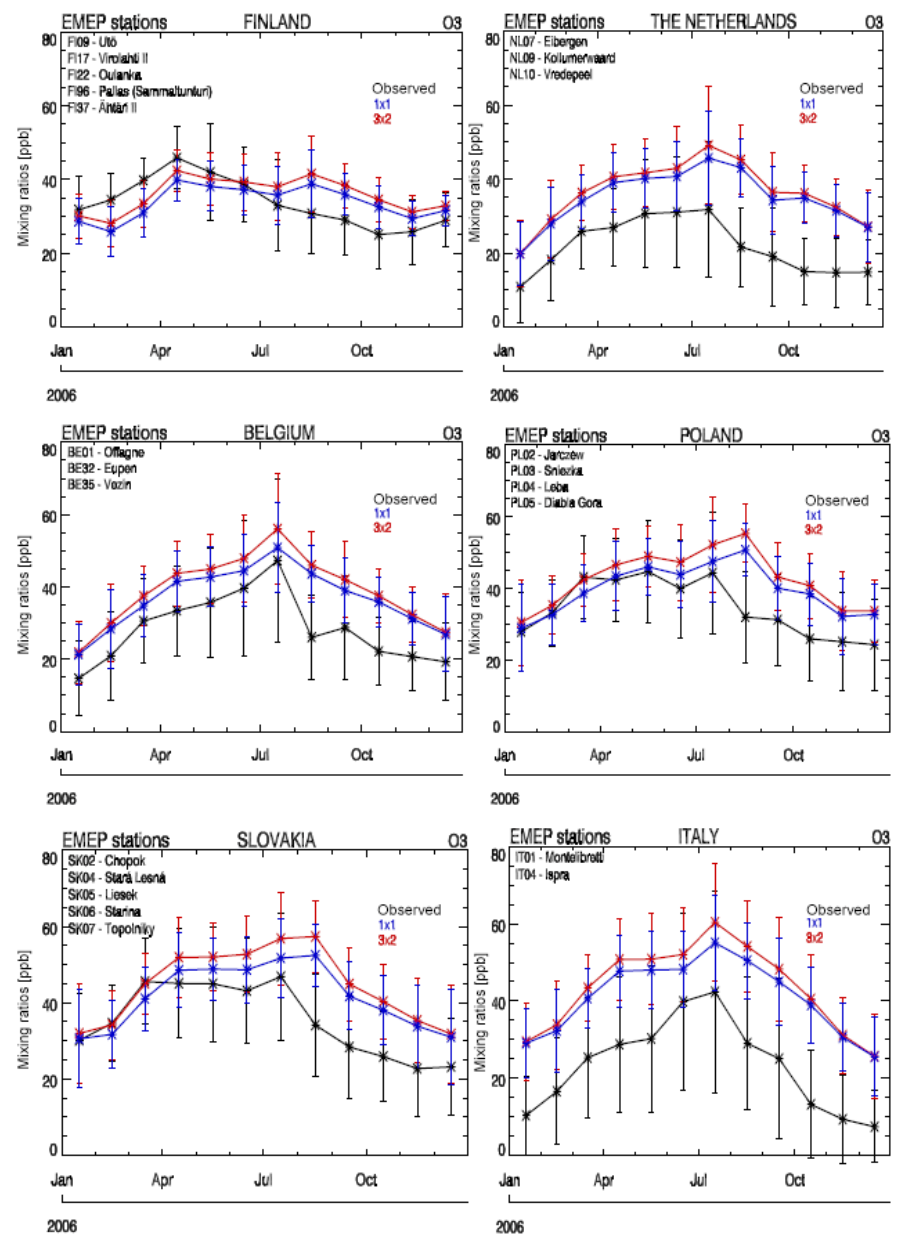
Figure 4. Comparisons of the seasonal variability in TM5-MP mass mixing ratios for surface O 3 against composites of measurements taken across the EMEP monitoring network for 2006. Both the co-located TM5-MP 3 ◦ × 2 ◦ and 1 ◦ × 1 ◦ monthly mean values are shown, along with the 1 σ variability for Finland, the Netherlands, Belgium, Poland, Slovakia and Italy. Individual stations that are aggregated are given in the